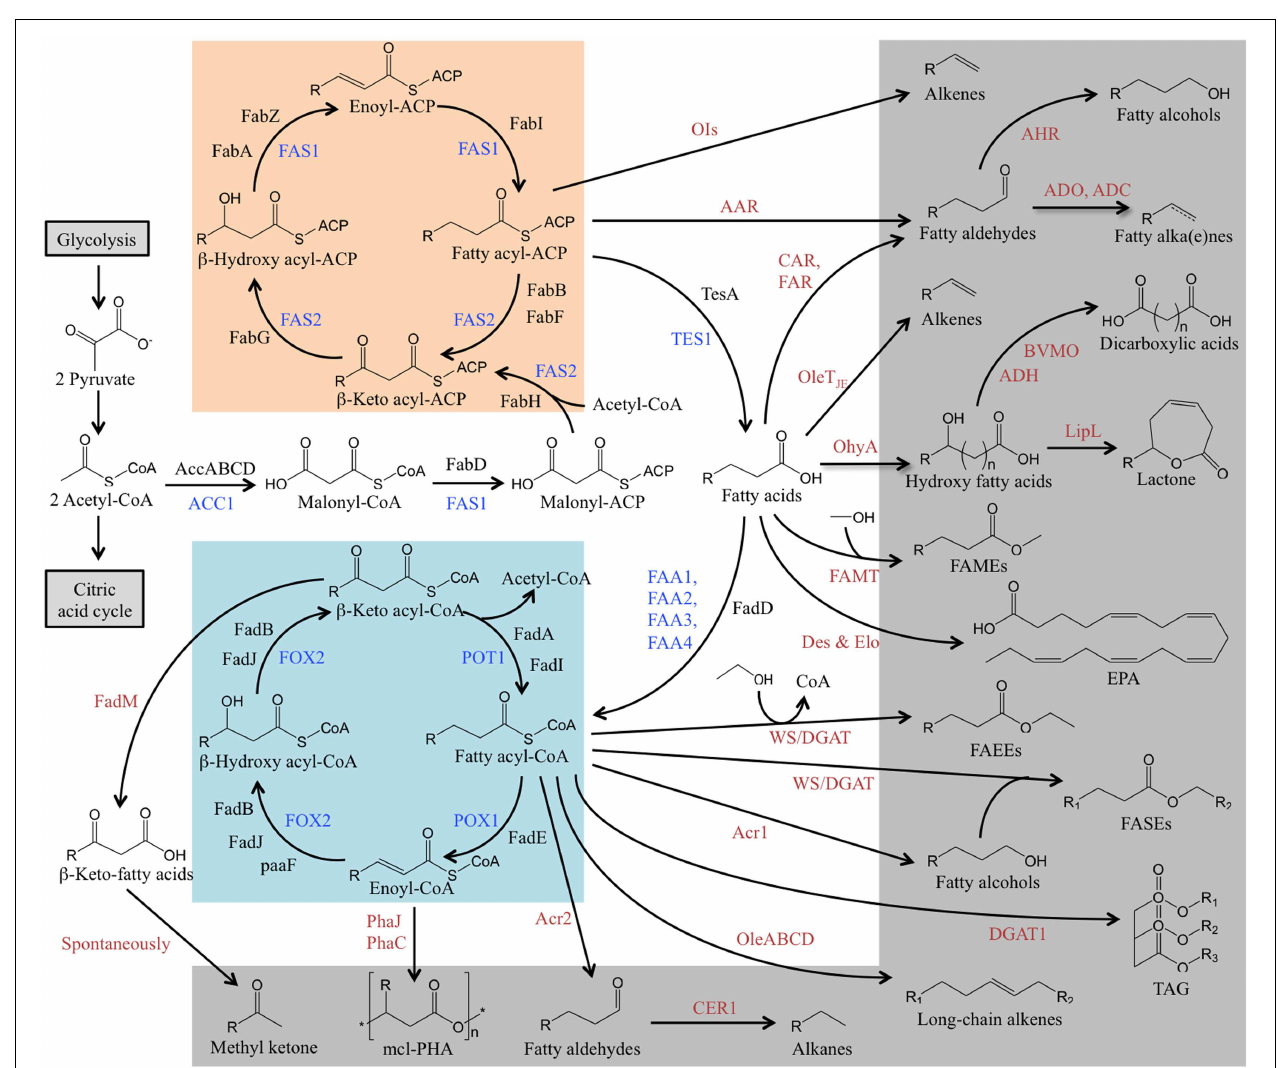
FIGURE 1 | Overview of metabolic pathways that lead to the production of fatty acids and fatty acid-derived chemicals .The fatty acid biosynthesis (orange), β -oxidation cycle (blue), and the biosynthesis pathway of fatty acid-derived chemicals (gray) are presented.The enzymes of fatty acid metabolism in S. cerevisiae is in blue, in E. coli is in black, and the enzymes for conversion of fatty acids to their derivatives from other organisms is in red. AAR, acyl-ACP reductase; ACC1, acetyl-CoA carboxylase; AccABCD, a four subunits, biotin carboxyl carrier protein (AccB), biotin carboxylase (AccC), and acetyl-CoA carboxytransferase (AccA, AccD); Acr1 & Acr2, acyl-CoA reductase; ADC, aldehyde decarbonylase; ADH, alcohol dehydrogenase; ADO, aldehyde-deformylating oxygenase; AHR, aldehyde reductase; BVMO, Baeyer–Villiger mono-oxygenase; CAR, carboxylic acid reductase; CER1, fatty aldehyde decarbonylase Des, fatty acid desaturase; DGAT1, acyl-CoA:diacylglycerol acyltransferase; Elo, fatty acid elongase; FAA1 & FAA4, long-chain fatty acyl-CoA synthetase; FAA2 & FAA3, fatty acyl-CoA synthetase; FabA & FabZ, β -hydroxy acyl-ACP dehydratase; FabB, β